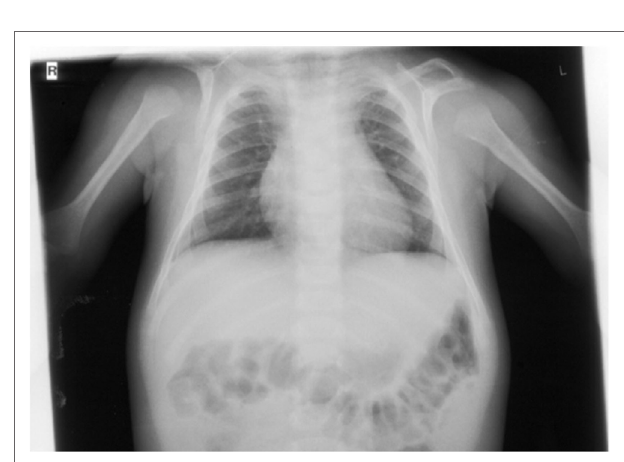
FIgURe 5 | X-ray (detail of a babygram) of the patient at the age of 7 months showing a hook-shaped hypoplastic left clavicle.